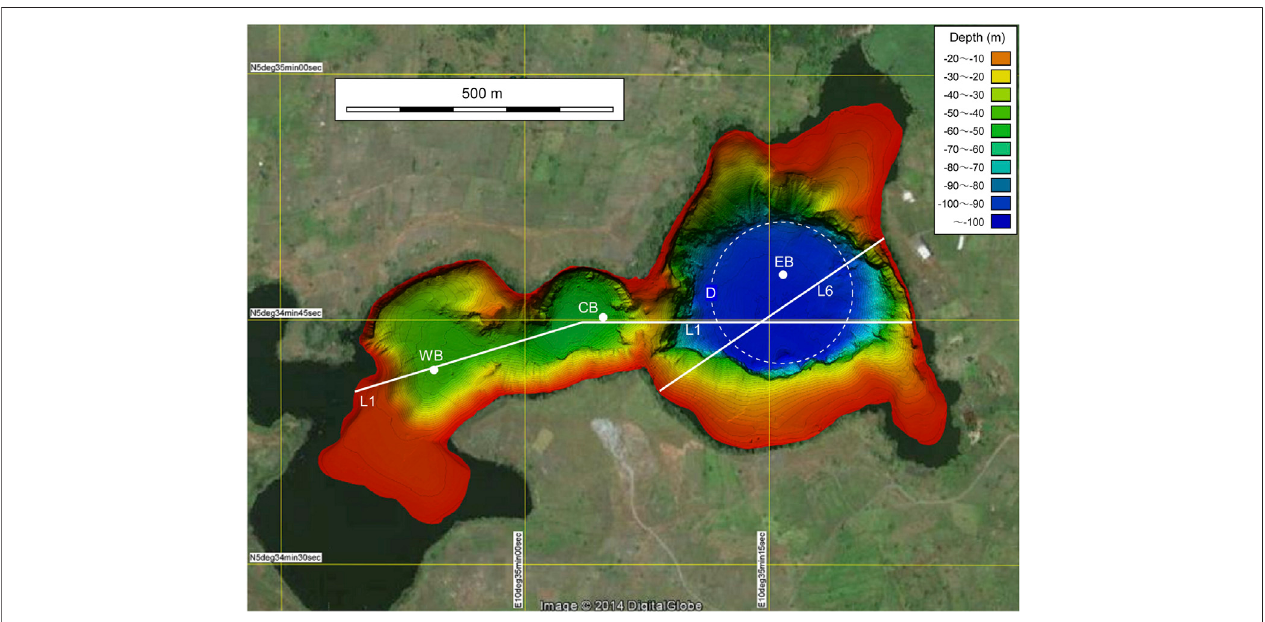
FIGURE2| Bathymetriesofthethreebasins WB,CB,andEBinLake Monoun. Dotsindicate thelocationofCTDmeasurements.Thevertical crosssections along lines L1 and L6 are shown in Figure 3A , Figure 9 , respectively. D is a potential diatreme ring fault, assuming that the shape of the fault is a true circle, and the fault includes D1, D2, and